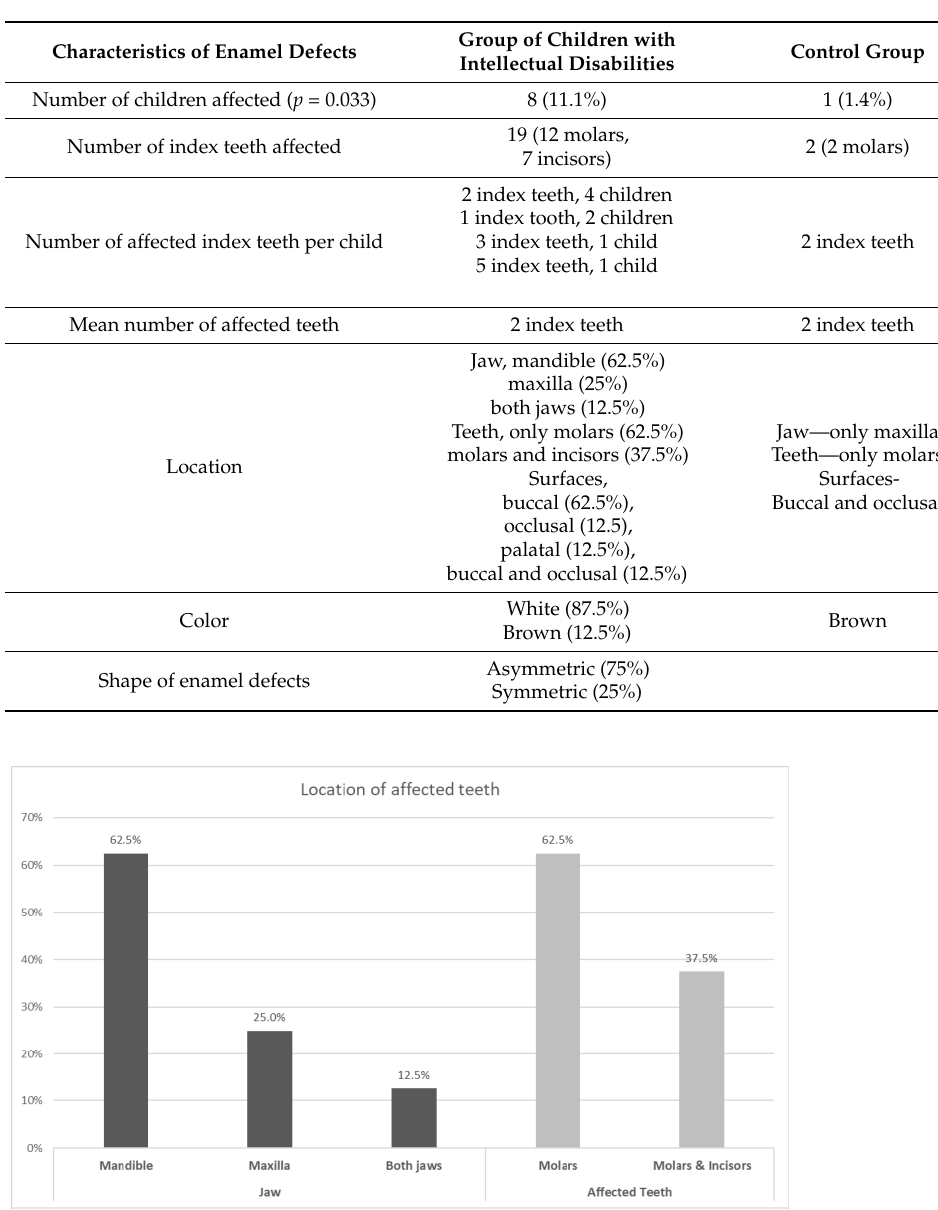
Table 3. Characteristics of enamel defects in examined children.